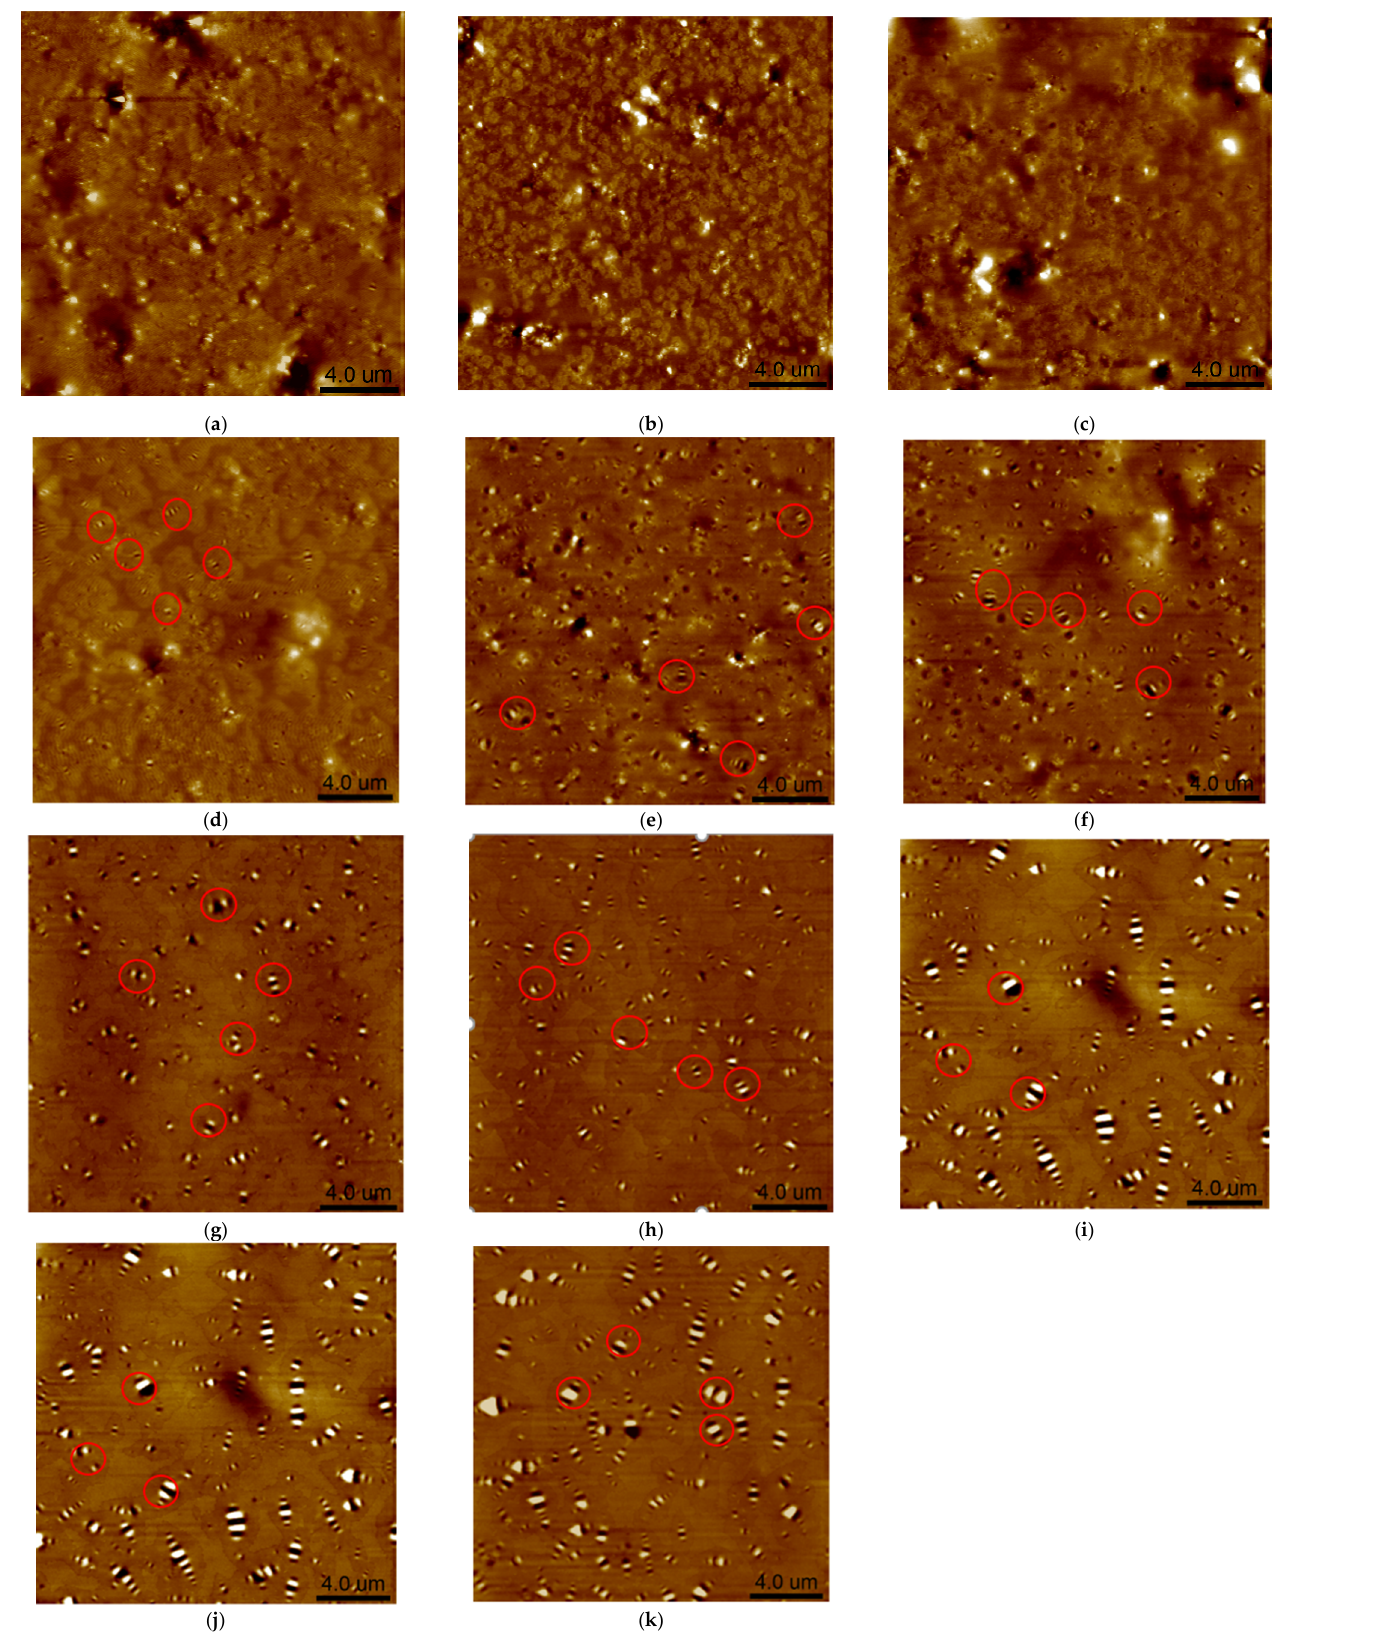
Figure 5. Changes in the “honeycomb” structure: ( a ) aging asphalt; ( b ) 5% + 20 min; ( c ) 5% + 40 min; ( d ) 5% + 60 min; ( e ) 6% + 20 min; ( f ) 6% + 40 min; ( g ) 6% + 60 min; ( h ) 7% + 20 min; ( i ) 7% + 40 min; ( j ) 7% + 60 min; and ( k ) original asphalt.